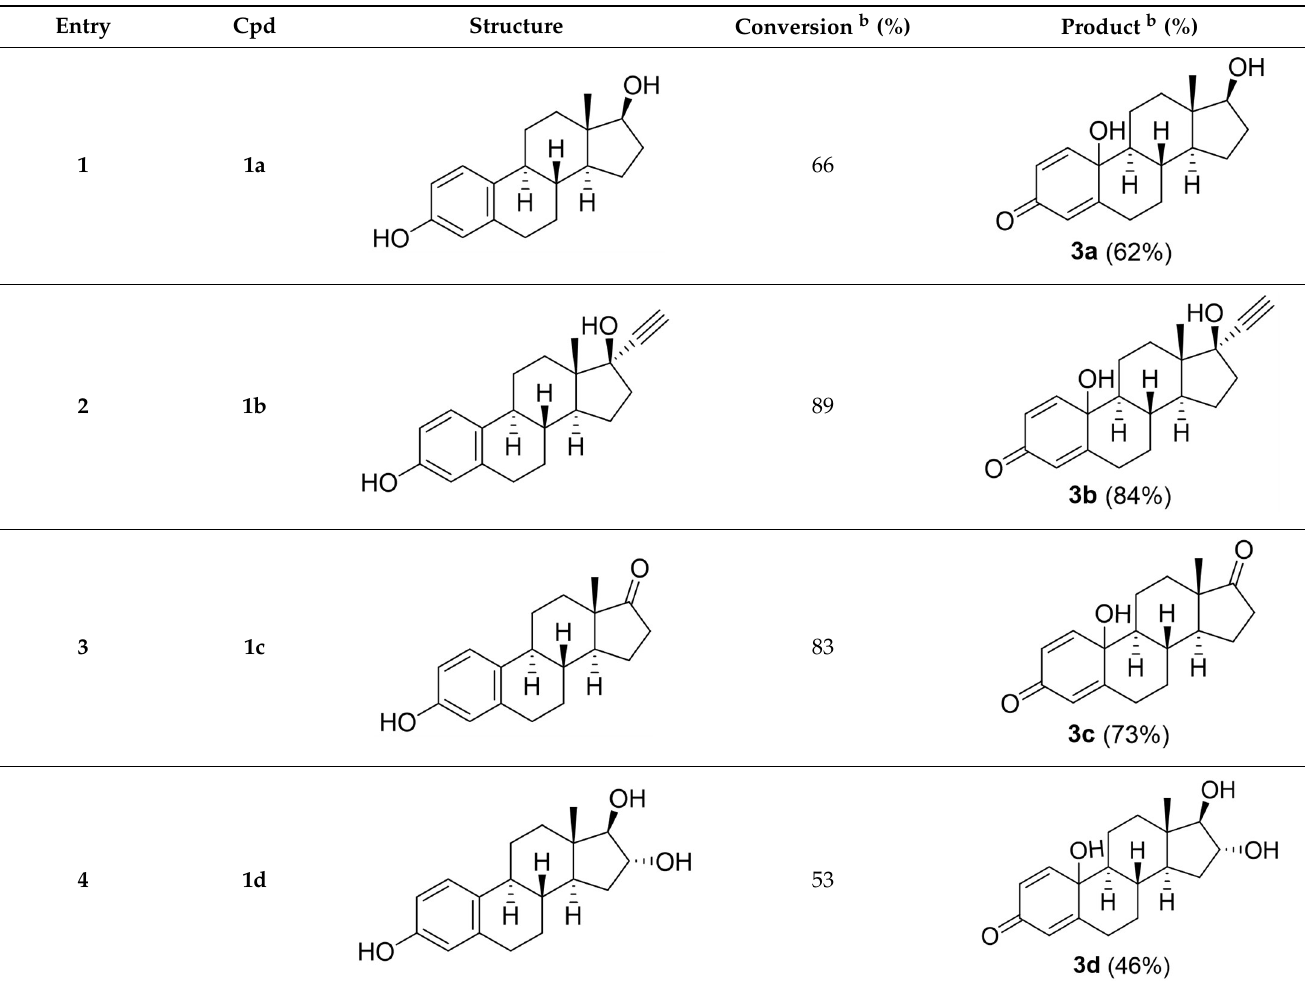
Table 5. Substrate scope of novel blue LED-driven two-liquid-phase in One-Pot condition a .